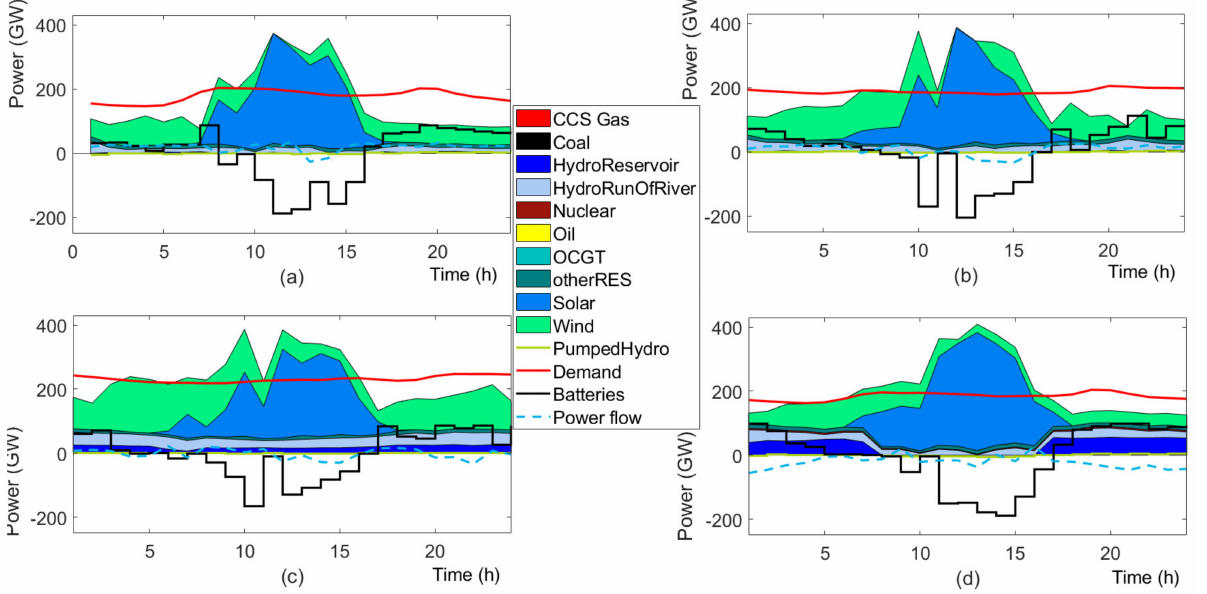
Figure 17. Generation mix in region NR according to scenario node 8 with the availability of storage, in four typical days. Figure ( a ) reports a typical day within the period January–March, ( b ) a typical day within April–June, ( c ) a typical